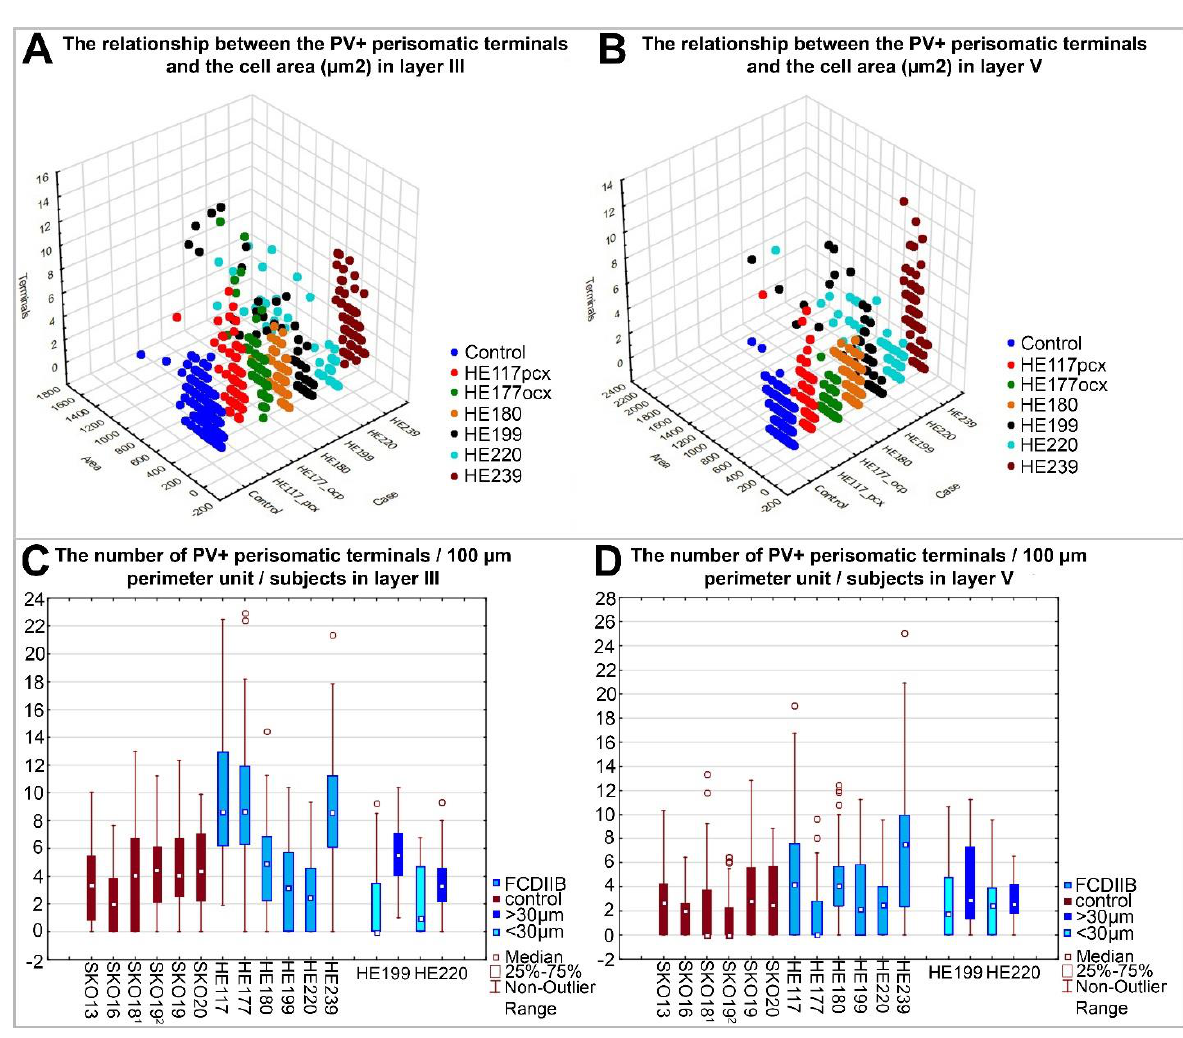
Figure 6. The soma area of individual NeuN-immunopositive cells and the number of PV-immunopositive perisomatic terminals contacting them are illustrated with a 3D scatterplot diagram in layer III ( A ) and layer V ( B ). Control cases are pooled due to minor variance and easier perspicuity. In the HE199 and HE220 FCDIIB samples the large neurons have larger input (black and light blue points). In the HE117, HE177 and HE239 samples the cell’s size is mostly control-like, with considerably increased number of PV-immunopositive perisomatic inputs (red, green and claret points) in layer III ( A ). Similar, but less considerable changes are visible in layer V, except for case HE239, where the input is much higher than in the control. HE180 shows control-like properties in soma size and input characteristics. The boxplots show the number of PV-immunopositive terminals calculated per unit-perimeter length (100 μm) of NeuN-immunopositive cell bodies per subject, in layer III ( C ) and layer V ( D ). Claret columns: control, blue columns: FCDIIB patients. In HE199 and HE220 FCDIIB samples the large neurons have larger input, compared to controls and the other subject with FCD. On the contrary, around the normal-sized cells (<30 μm) there are fewer labeled terminals than in the controls and around the giant cells in layer III (royal blue columns: long diameter of cells is larger than 30 µm, sky-blue columns: long diameter of cells is less than 30 µm). The neurons of the cases HE117 and HE177 have increased PV-immunopositive input in layer III ( C ). Around the cells of HE180 and HE239 there is a higher number of PV-immunopositive terminals than in control samples in both measured layers. Circles: outliers 1: pcx, 2: ocx.